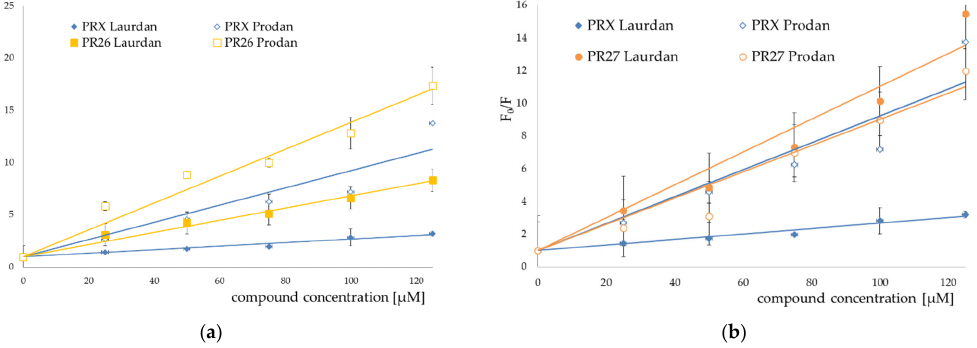
Figure 9. Stern–Volmer plots for PR26 ( a ) and PR27 ( b ) induced quenching of Laurdan (full symbols) and Prodan (open symbols) fluorescence; mean ± SD, n = 3.